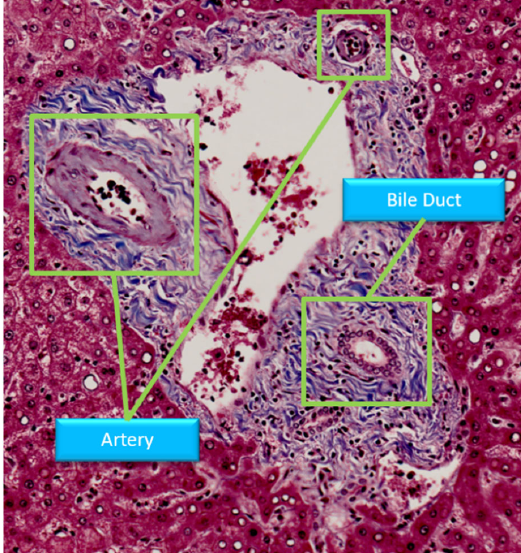
Figure 1. Structure of portal area in Masson stain.